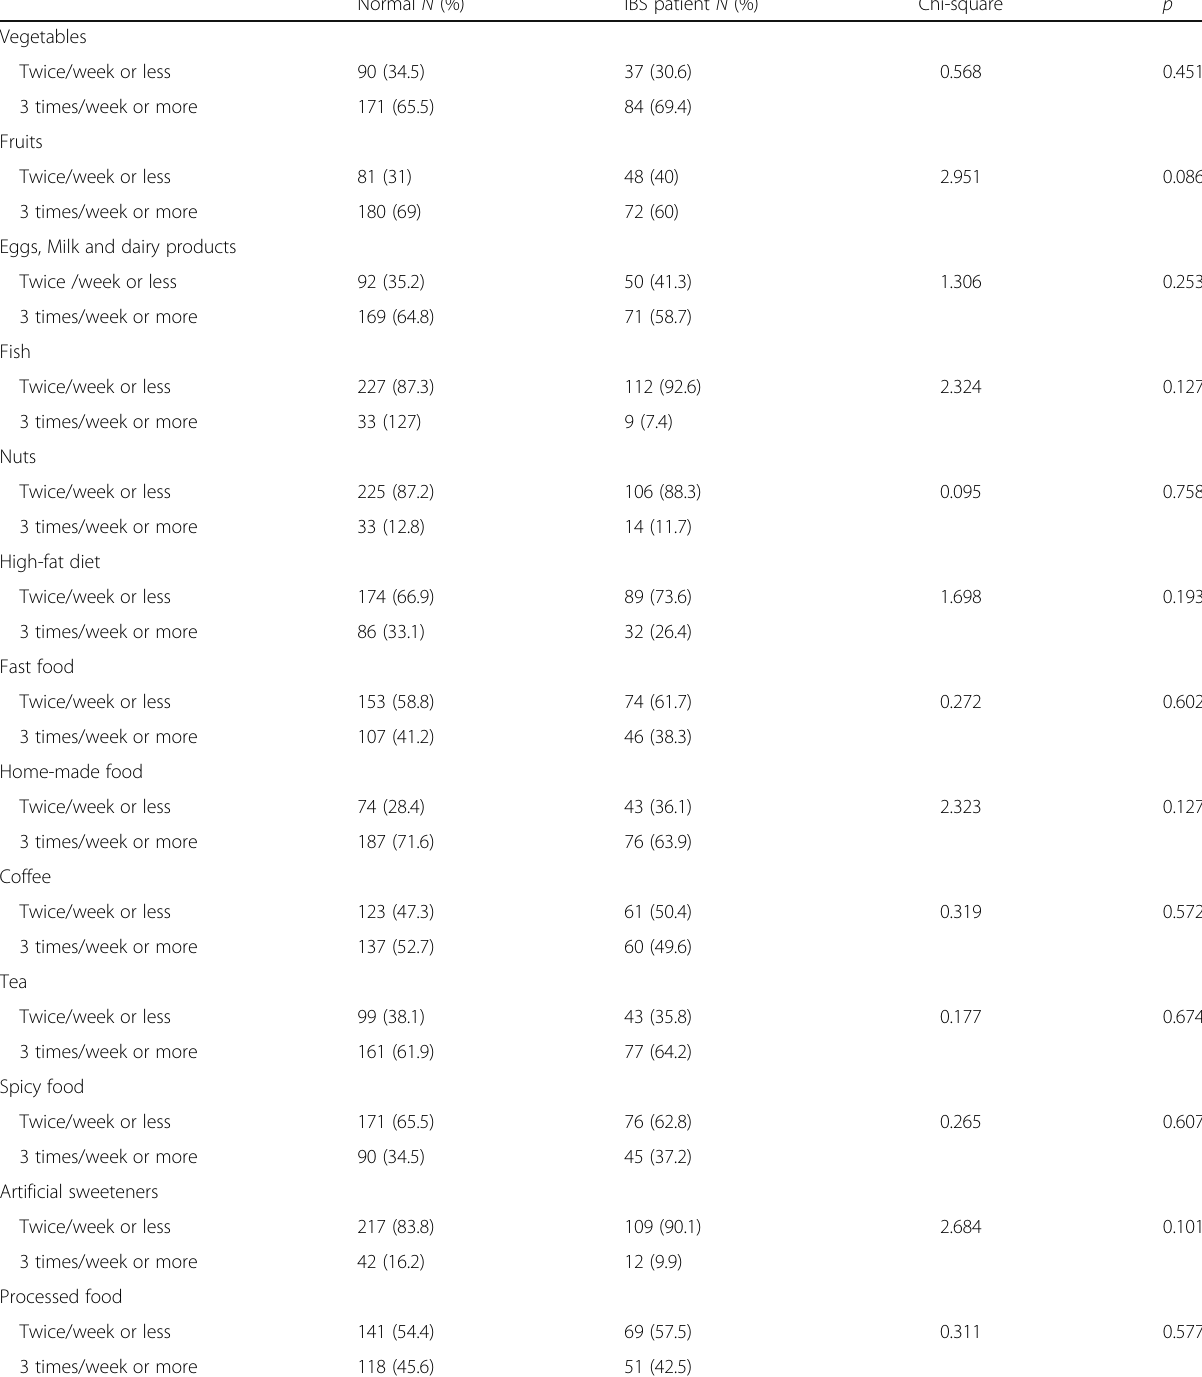
Table 4 Comparison between IBS patients and normal students regarding food frequency questionnaire Normal N (%) IBS patient N (%) Chi-square